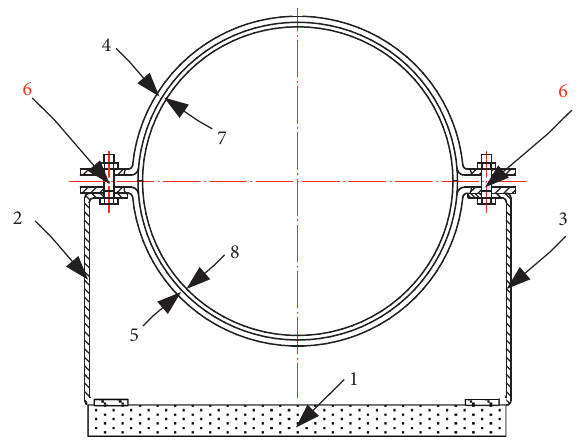
Figure 3: Cross section view of the clamping support structure with cargo